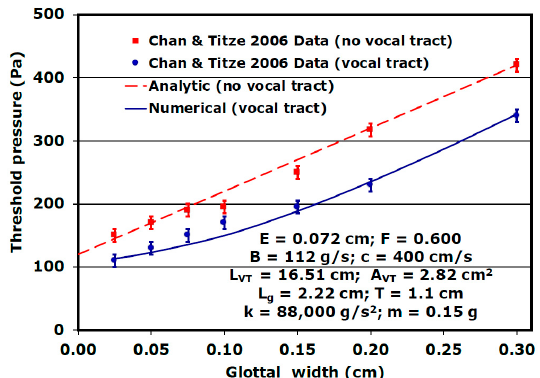
Figure 2. (Color online) Measured and calculated phonation threshold pressures as functions of the glottal half-width with and without a vocal tract.